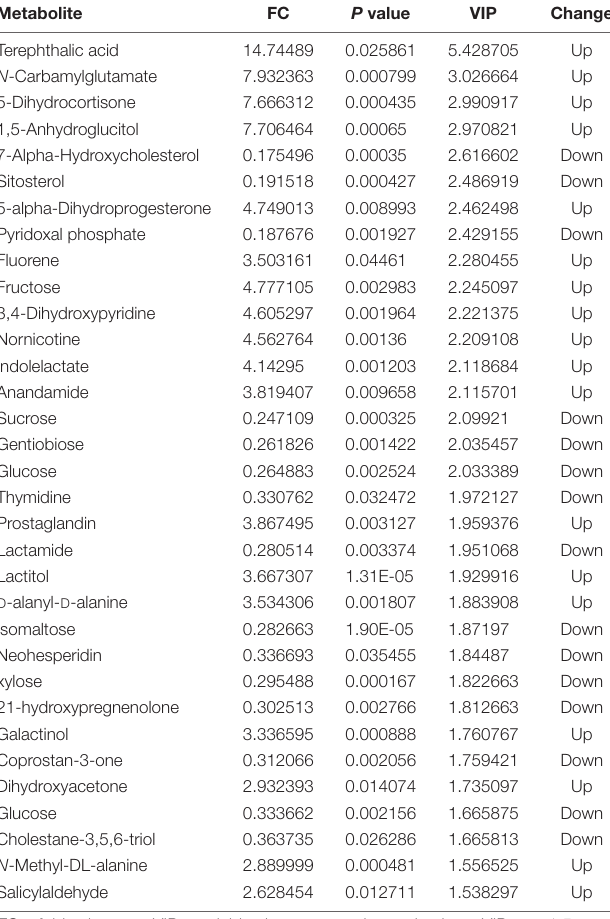
TABLE 1 | Metabolomic analysis of the sugar beet root exudates in T3 compared to